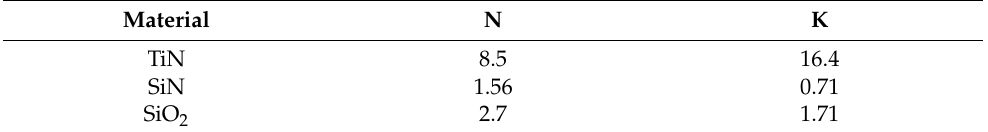
Table A1. Refractive index of TiN, SiN, and SiO 2 at λ = 9.5 µ